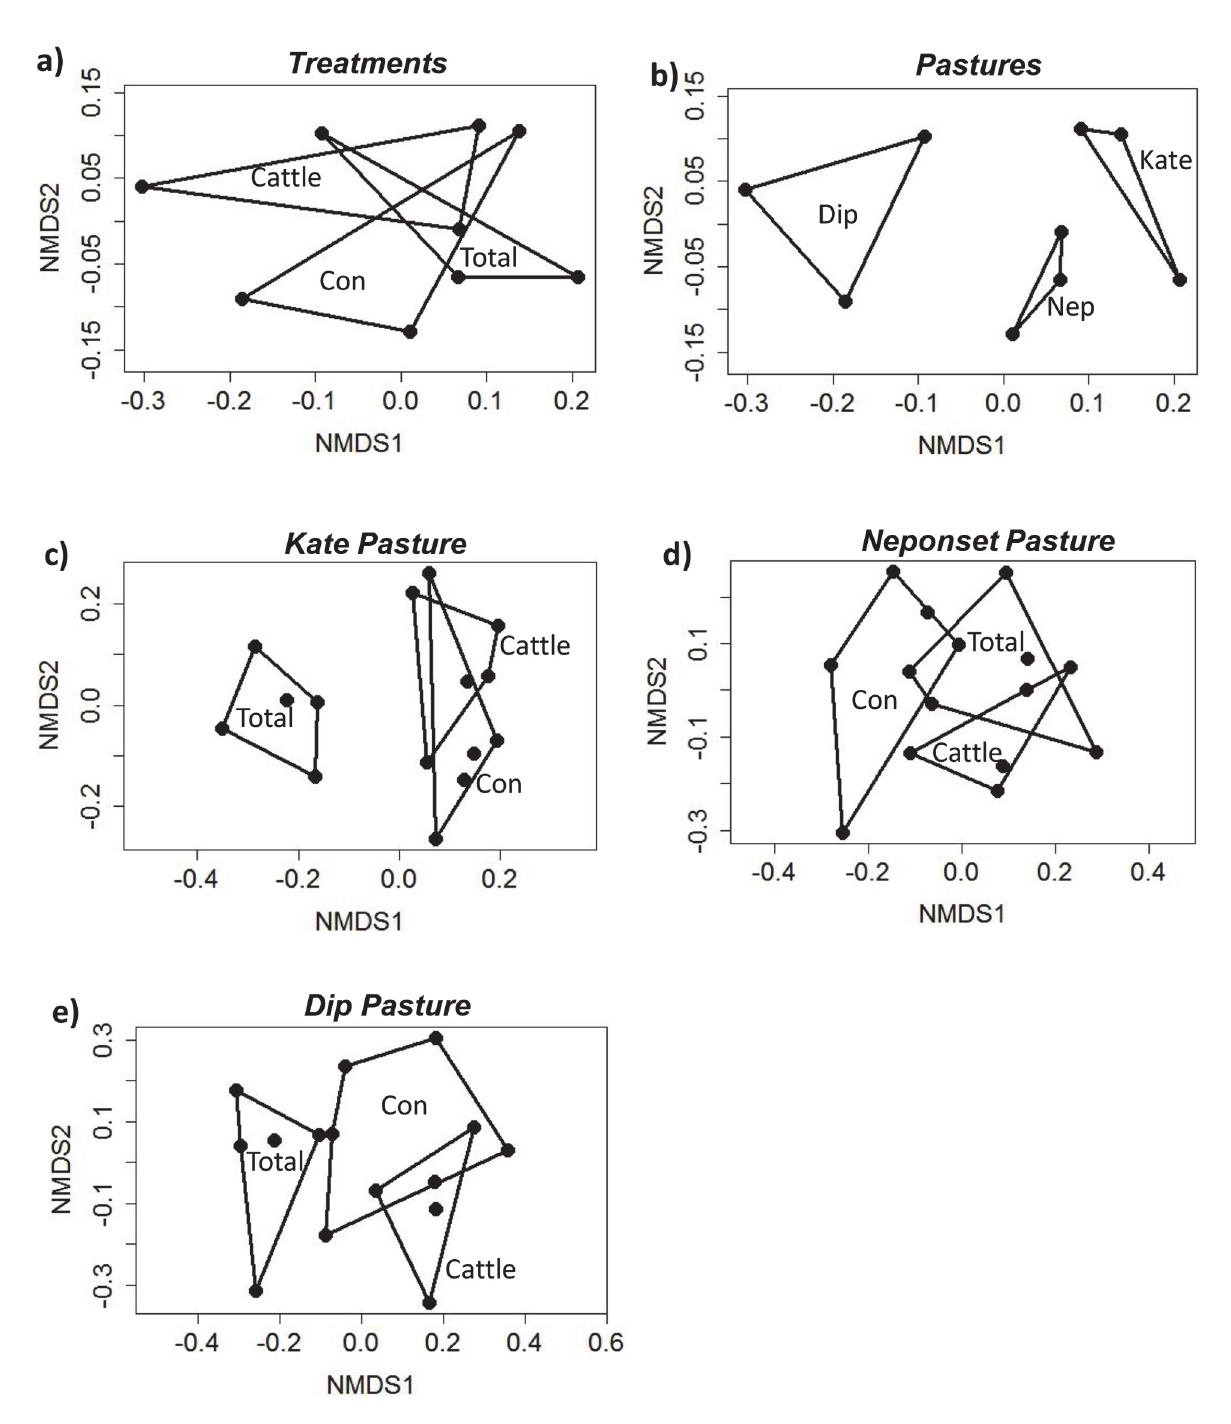
Fig 2. NMDS results. Non-metric Multidimensional Scaling (NMDS) results depicting sample points and convex hulls for (a) three herbivore treatments and (b) three pastures in relation to plant species community composition (n = 125 frequency frames per sample point); and (c-e) treatments within individual pastures (n = 25 frequency frames per sample point). Total, Cattle, and Control treatments exclude, respectively, all large herbivores, cattle only, and no large herbivores.